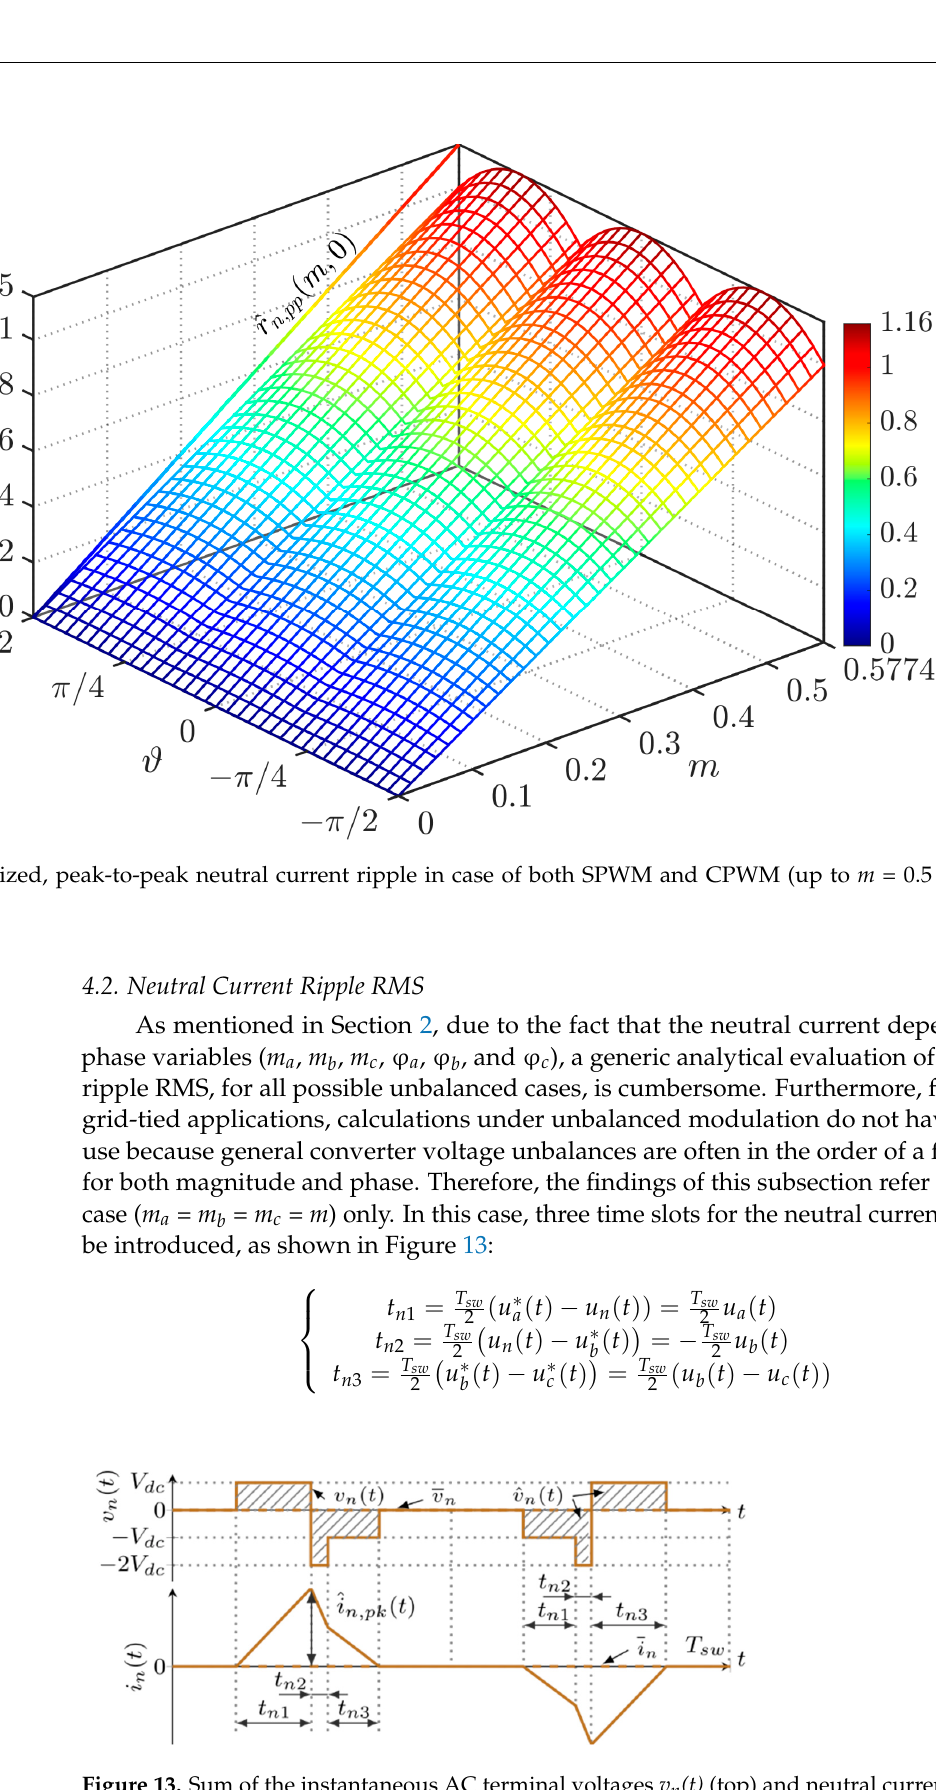
Figure 13. Sum of the instantaneous AC terminal voltages v n (t) (top) and neutral current ripple î n (t) (bottom) in one switching period for a generic PWM method.